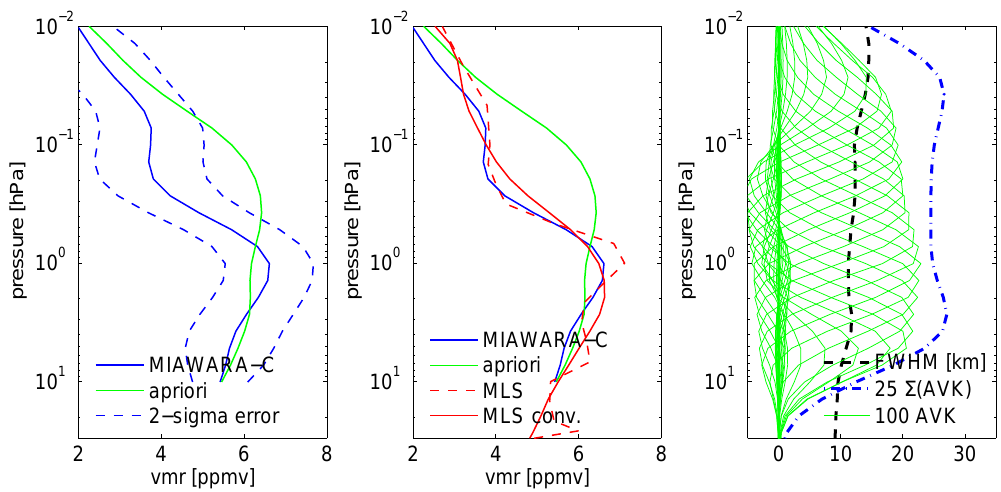
Fig. 12. Water vapor profile retrieved from the one day spectrum shown in Fig. 11 plotted together with the apriori profile and the upper limit for the systematic plus random 2- σ error and compared to the profile of a close MLS overpass (67.5 ◦ N, 21.0 ◦ E) in the middle plot. The averaging kernels of MIAWARA-C are shown on the right together with the FWHM and the sum of each of the kernels.